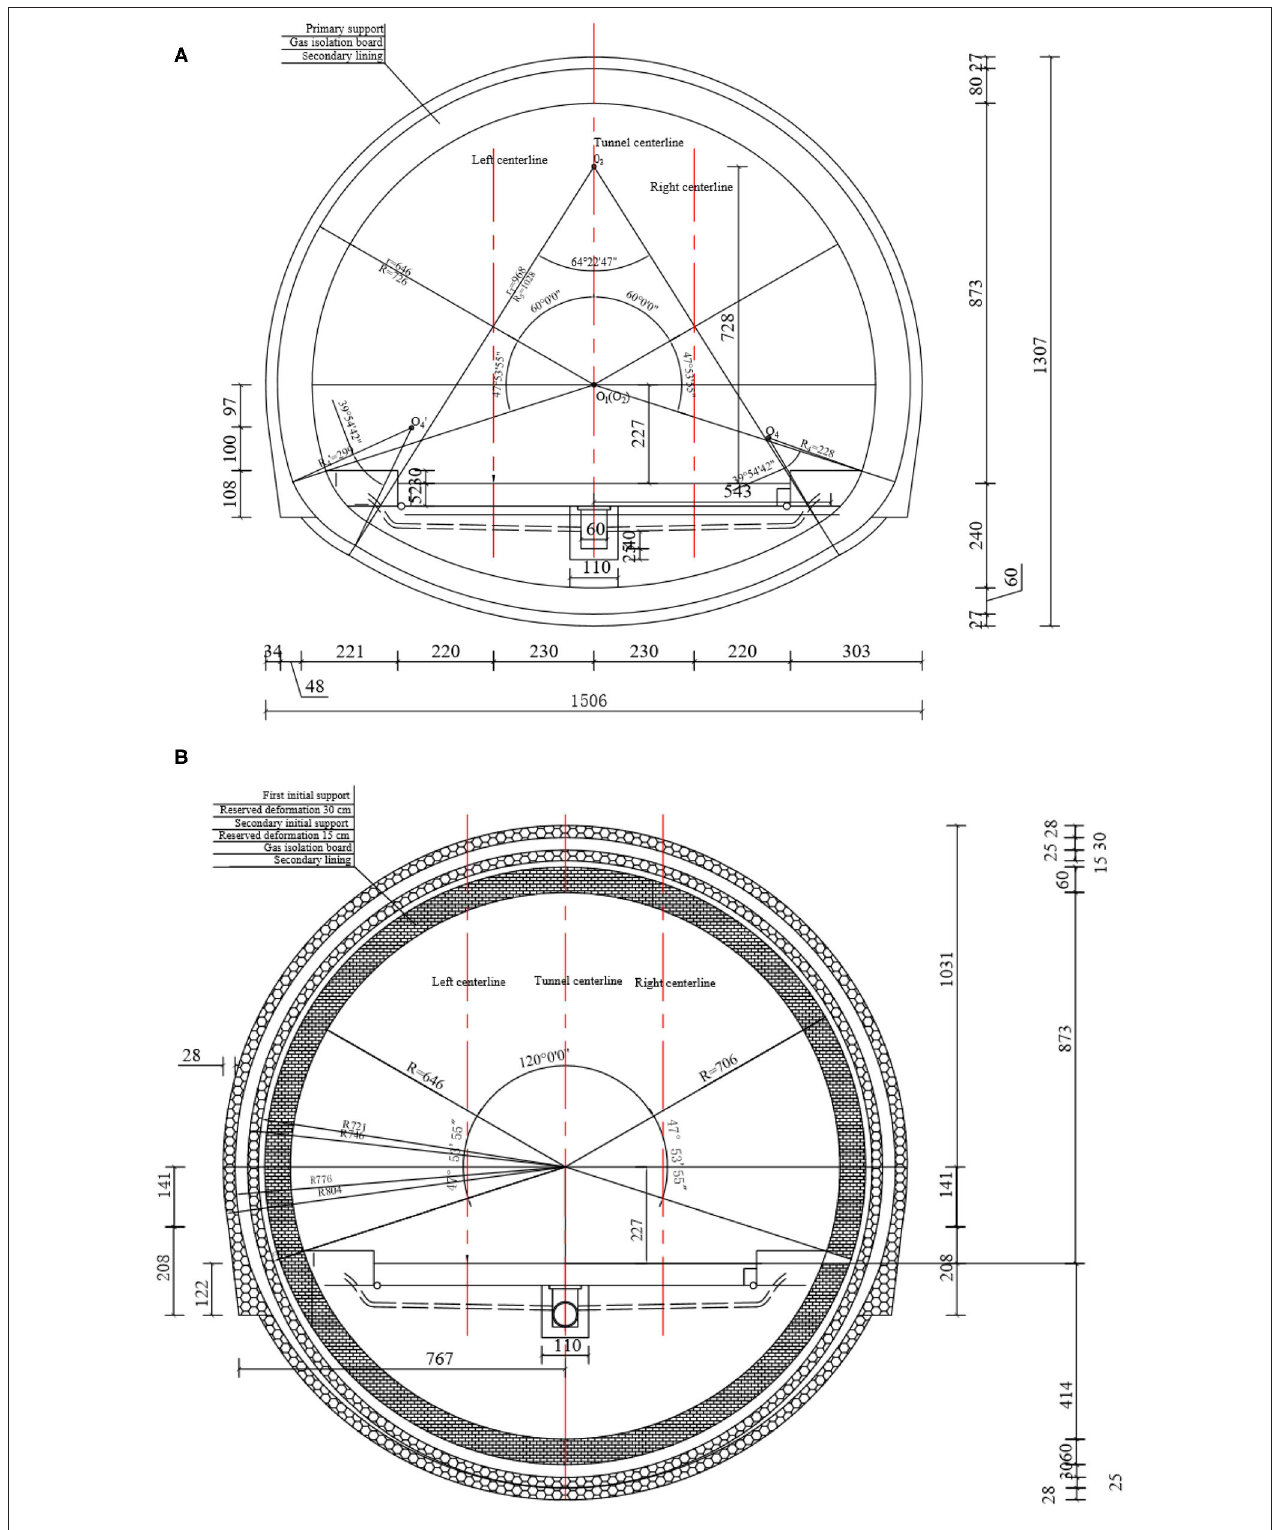
FIGURE 4 | Section structure parameters: (A) Type III composite lining section. (B) Type IV composite lining.